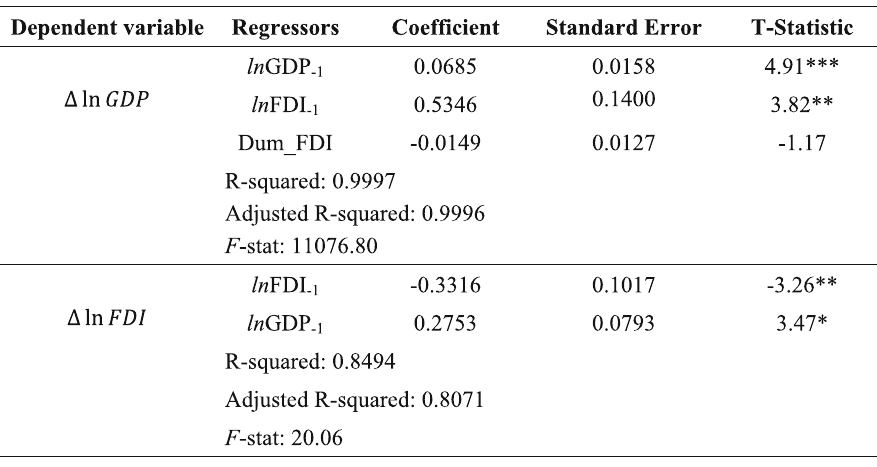
Table 3 Augmented ARDL model estimation results